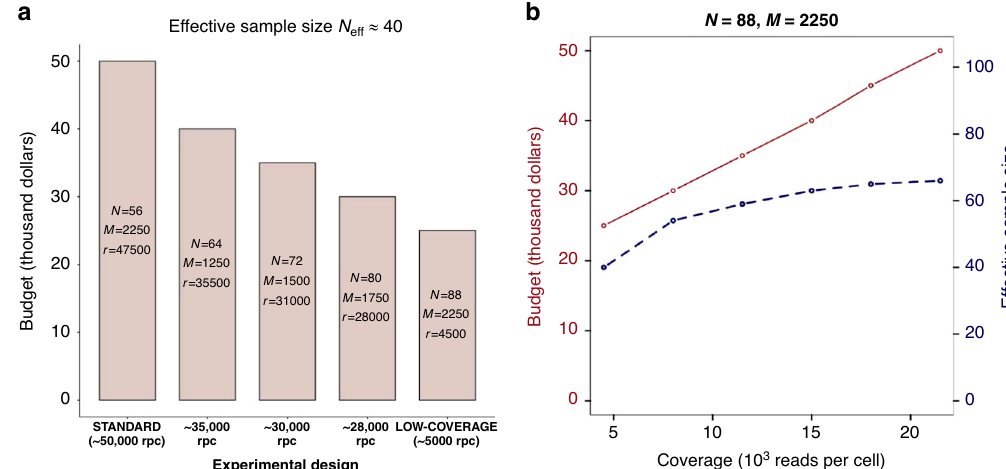
Fig. 4 Experimental designs for CD4 T cells ct-eQTL with effective sample size N eff = 40. a Comparison of different experimental designs. Experimental design N = 88, M = 2250, r = 4500 yields 2-fold reduction in cost than the standard design. b For a fi xed sample size and number of cells per individual, increasing coverage implies increasing the effective sample size (i.e., power) only up to a point. There is little gain in power at coverages greater than 12,500 reads per cell. Red solid line corresponds to budget and blue dashed line corresponds to effective sample size.